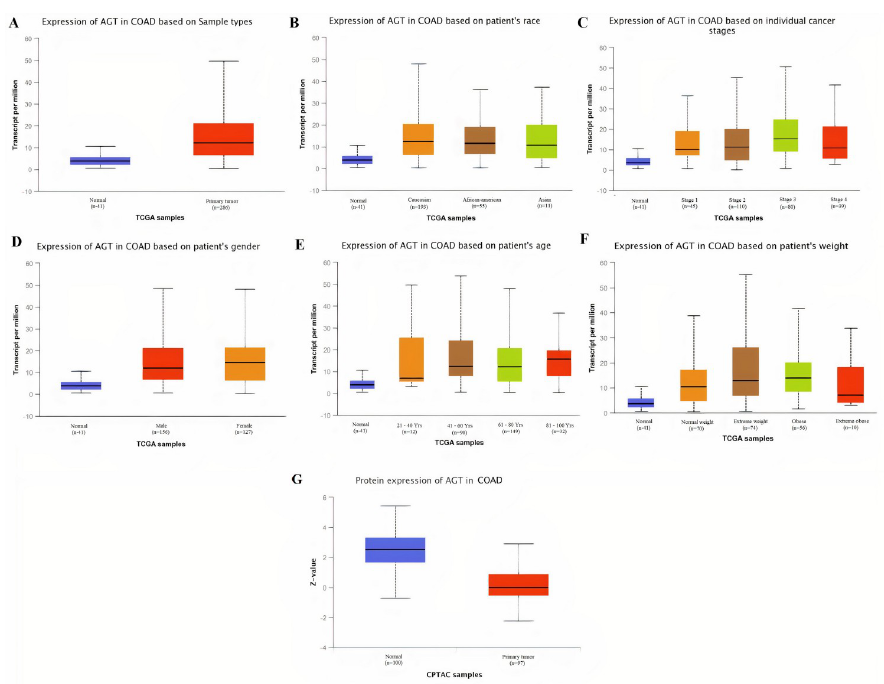
Fig 7. Box plots showing the relative expression levels of AGT in normal and COAD samples of different clinicopathological features via UALCAN database. Relative mRNA expression of AGT: (A) in normal individuals and COAD patients; (B) in normal individuals and COAD patients of different races; (C) in normal individuals and COAD patients of different cancer stages; (D) in normal individuals and COAD patients of different genders; (E) in normal individuals and COAD patients of different age groups; and, (F) in normal individuals and COAD patients of different body weights; (G) Relative protein expression of AGT in normal individuals and COAD patients. A p-value of < 0.05 was considered significant. Normal weight = BMI greater than or equal to 18.5 and BMI less than 25, Extereme weight = BMI greater than or equal to 25 and BMI less than 30, Obese = BMI greater than or equal to 30 and BMI less than 40, and Extreme Obese = BMI greater than